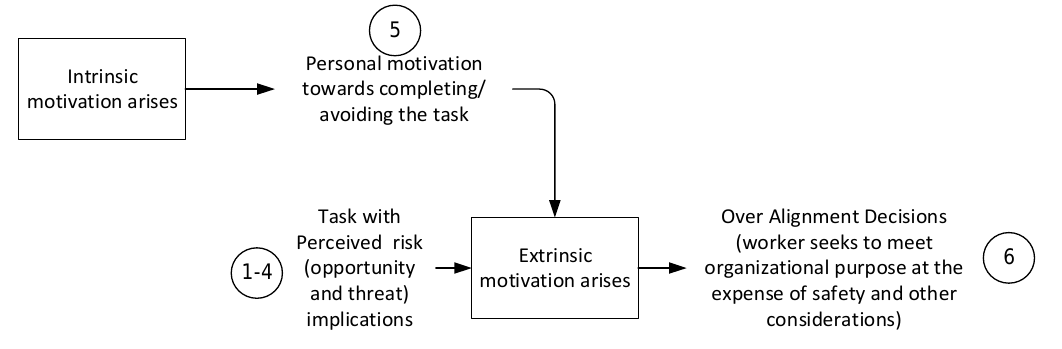
Figure 4. Motivation Arises towards the task.